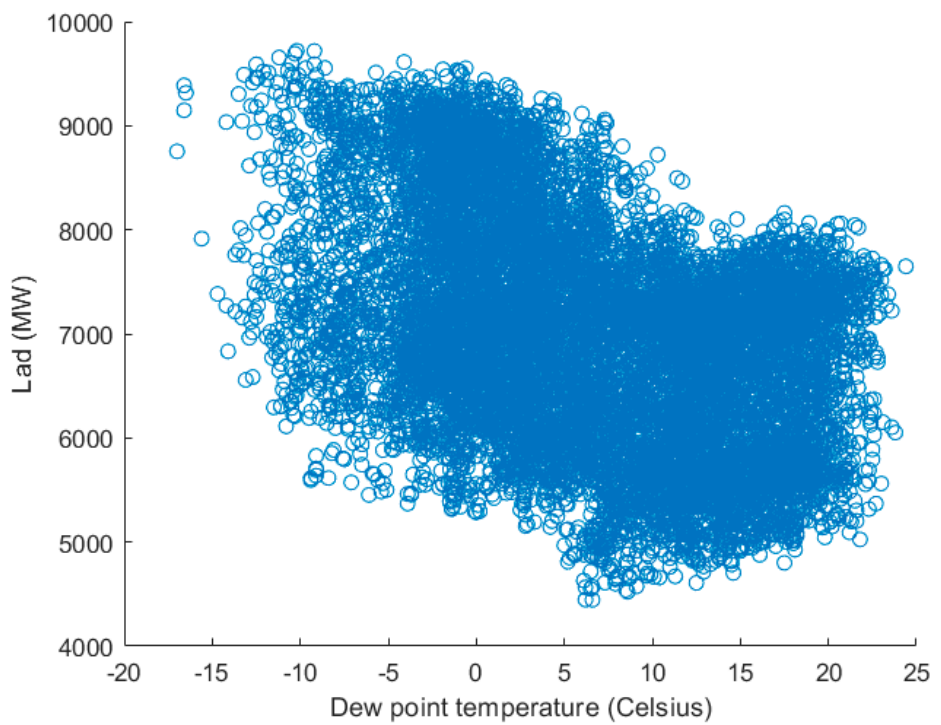
Figure 5. Energy load—dew point